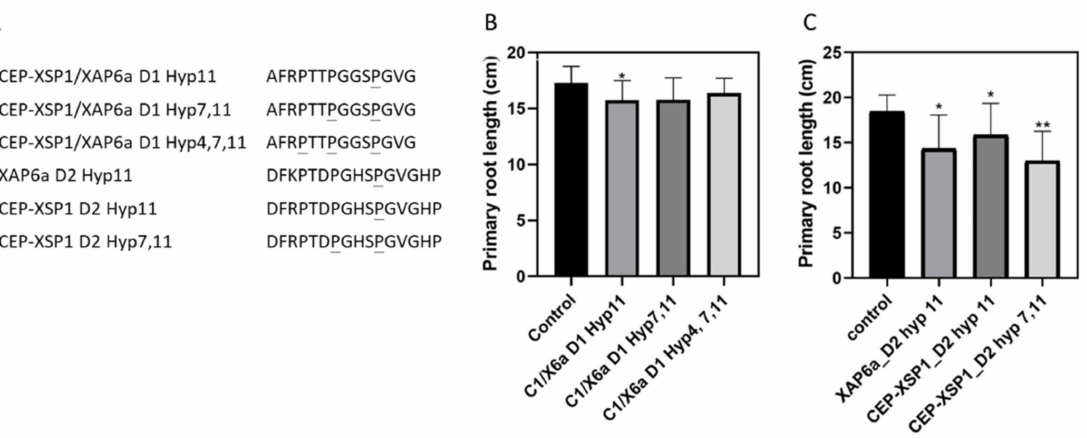
Figure 5. Biological activity of synthetic peptides of CEP-XSP1 and XAP6a: ( A ) modified